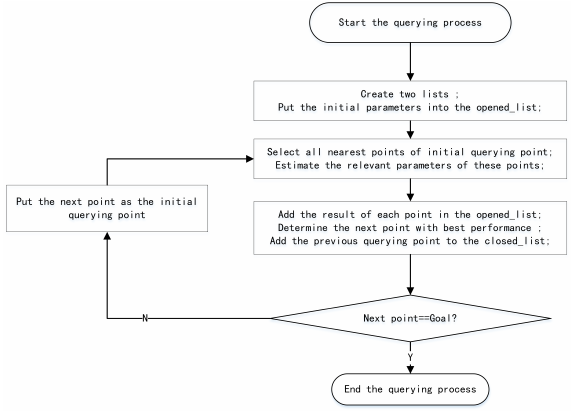
Figure 2. The querying process of typical PRM